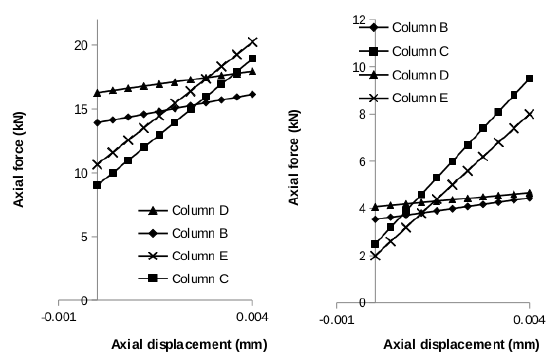
Figure 5: Axisymmetric model mesh density. Figure 6: Force- displacement results from 3D and axisymmetric models with coefficient of friction 0 and 0.3: (a) small band (ra- dius=157 mm) (b) large band (radius=557